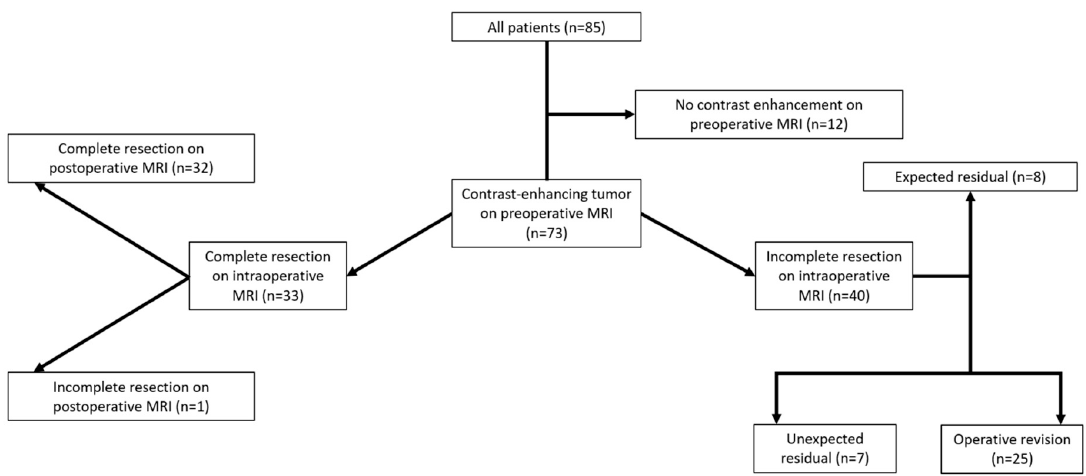
Figure 1. Flow chart for surgical outcome and extent of resection based on evaluation of pre-, intra-, and postoperative imaging.